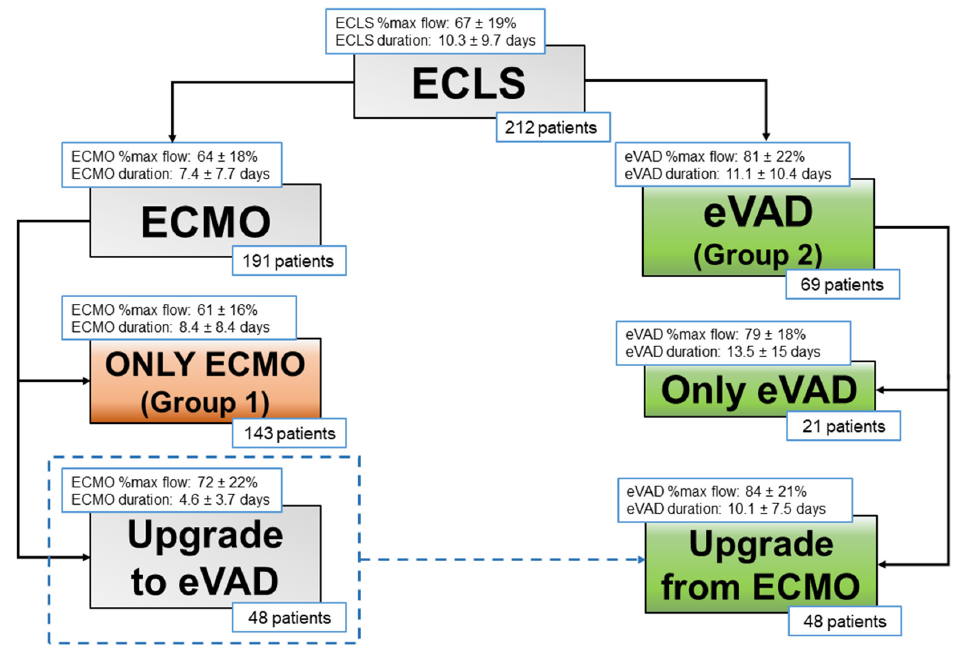
Figure 1. Study population groups.